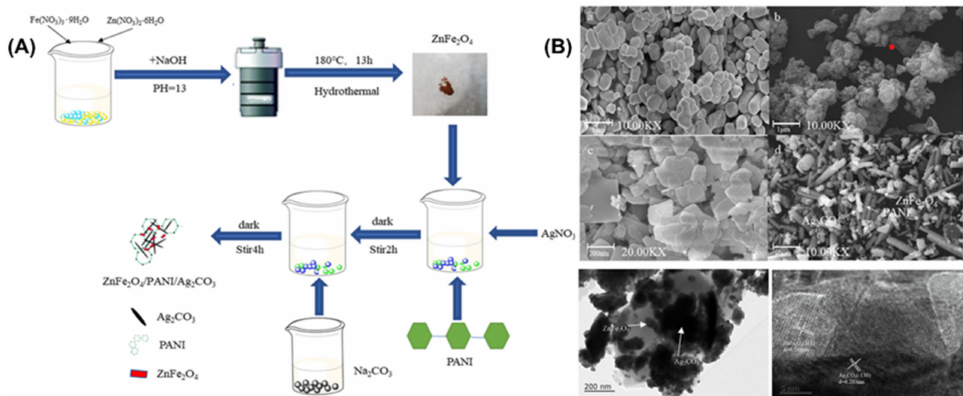
Figure 4. ( A ) Synthesis of ZnFe 2 O 4 /PANI/Ag 2 CO 3 composite using hydrothermal/co-precipitation method and ( B ) Photograph showing SEM images of ( a ) Ag 2 CO 3 , ( b ) PANI, ( c ) ZnFe 2 O 4 , ( d ) ZnFe 2 O 4 /PANI/Ag 2 CO 3 , TEM image of ( e ) ZnFe 2 O 4 /PANI/Ag 2 CO 3 , and HRTEM images of ( f ) ZnFe 2 O 4 /PANI/Ag 2 CO 3 . Reproduced with permission from [74].